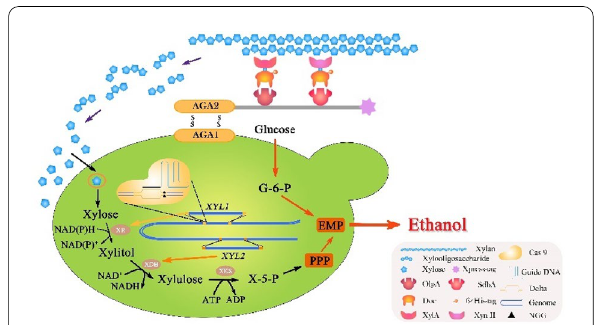
Fig. 2 Schematic diagram of the designer cellulosome self-assembled on the cell surface of xylose-utilizing recombinant S. cerevisiae strain WA1 g under the optimization of δ-integration CRISPR Cas9